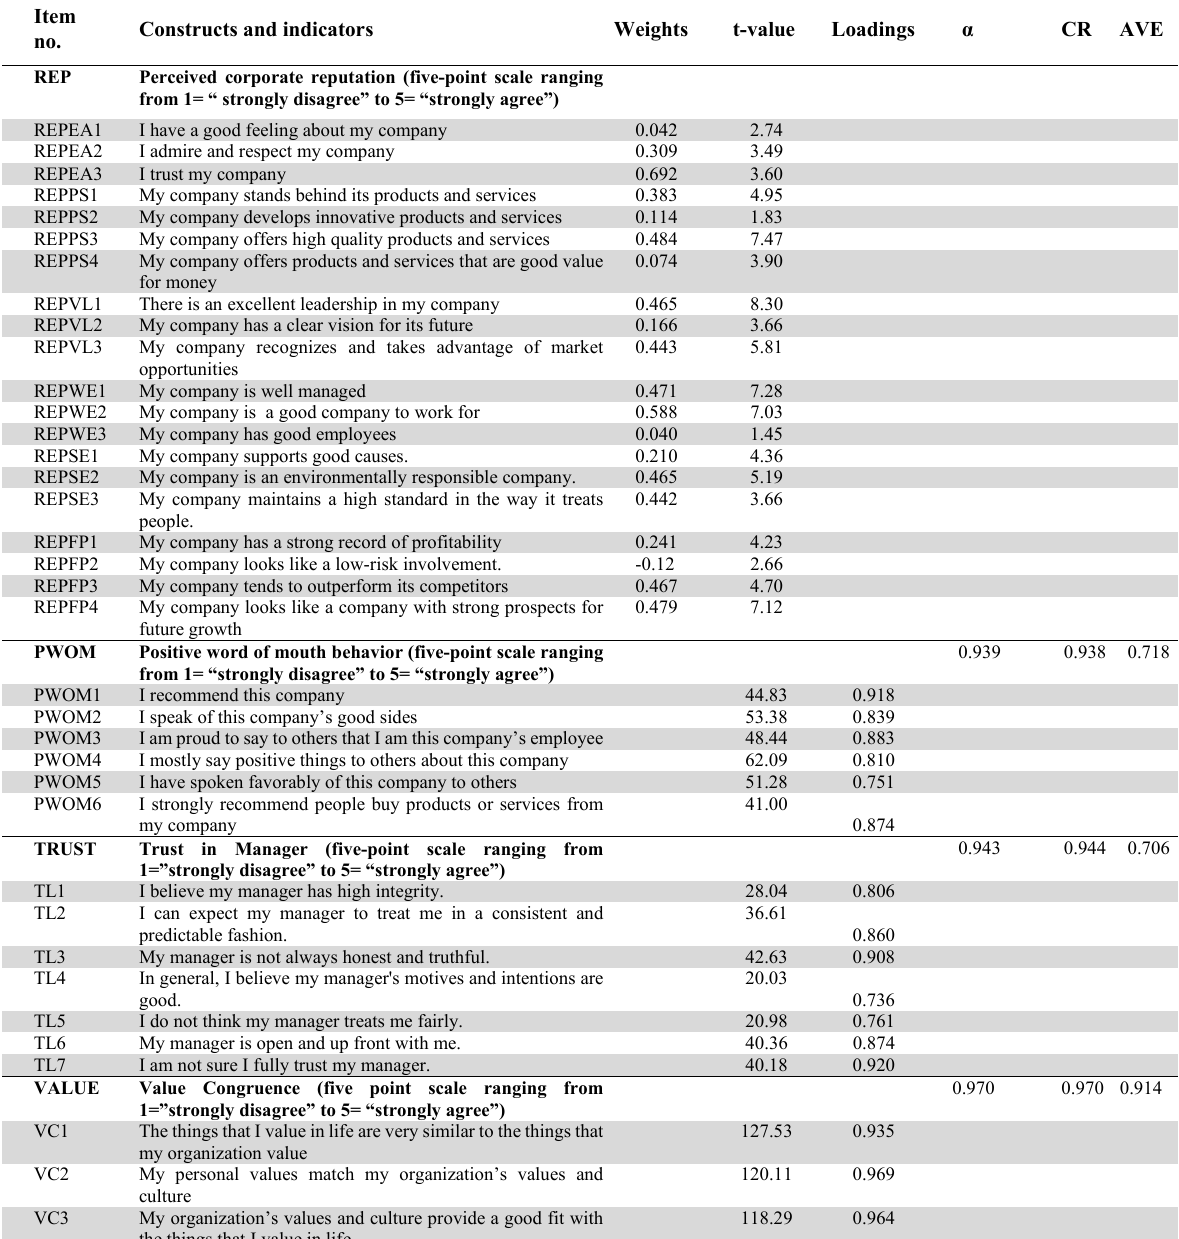
Information on the measurement